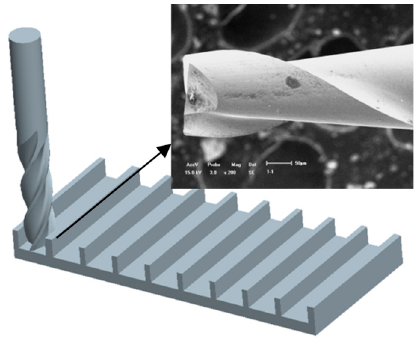
Figure 7. Micro groove milling sketch view.